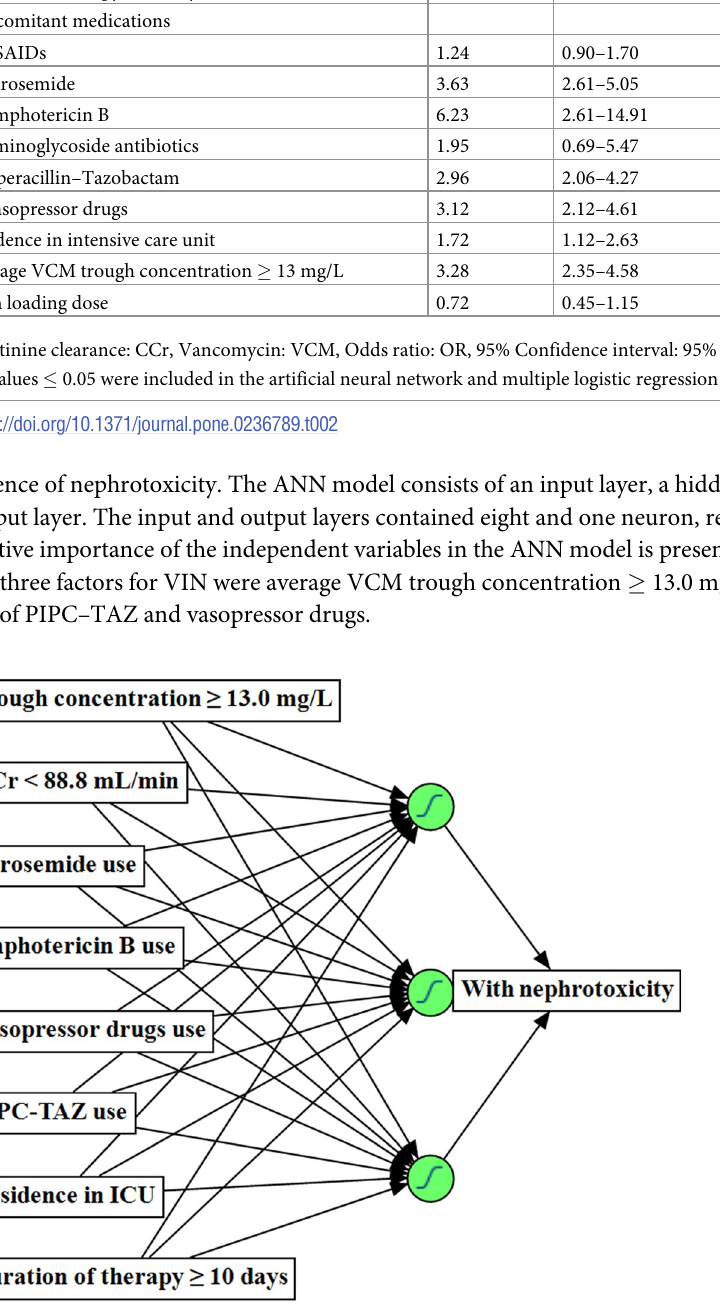
Fig 2. ANN model predicting VCM-induced nephrotoxicity. Creatinine clearance: CCr, Average vancomycin trough concentration: Trough concentration, Intensive care unit: ICU, Piperacillin–Tazobactam: PIPC–TAZ.